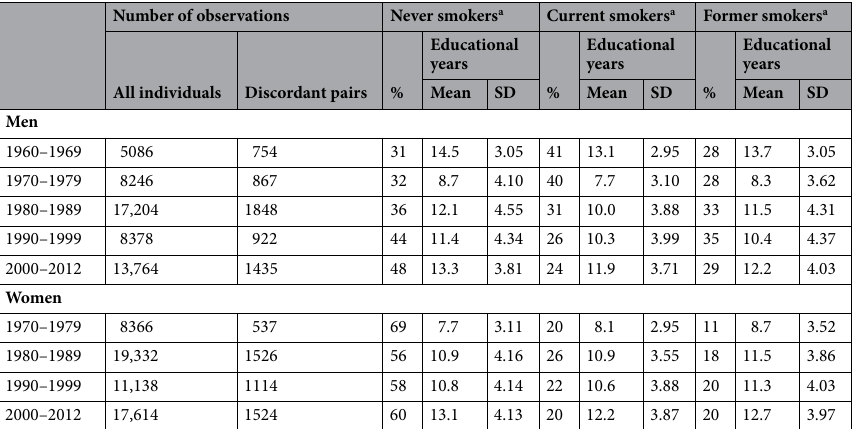
Table 1. Number of observations and descriptive statistics of educational years by smoking status, measurement year and sex. Twin cohorts from the following countries were included in the analyses: Australia (Queensland Twin Register, Twin Research Australia), China (Qingdao Twin Registry), Belgium (East Flanders Prospective Twin Survey), Finland (FinnTwin12, FinnTwin16, Finnish Older Cohort), Hungary (Hungarian Twin Registry), Italy (Italian Twin Registry), Japan (Osaka University Aged Twin Registry), Norway (Norwegian Twin Registry), South Korea (Korean Twin-Family Register), Spain (Murcia Twin Registry), Sweden (Swedish Twin Registry, Swedish Young Male Twins Study) and USA (Mid Atlantic Twin Registry, NAS-NRC Twin Cohort, Vietnam Era Twin Registry). a Calculated within all